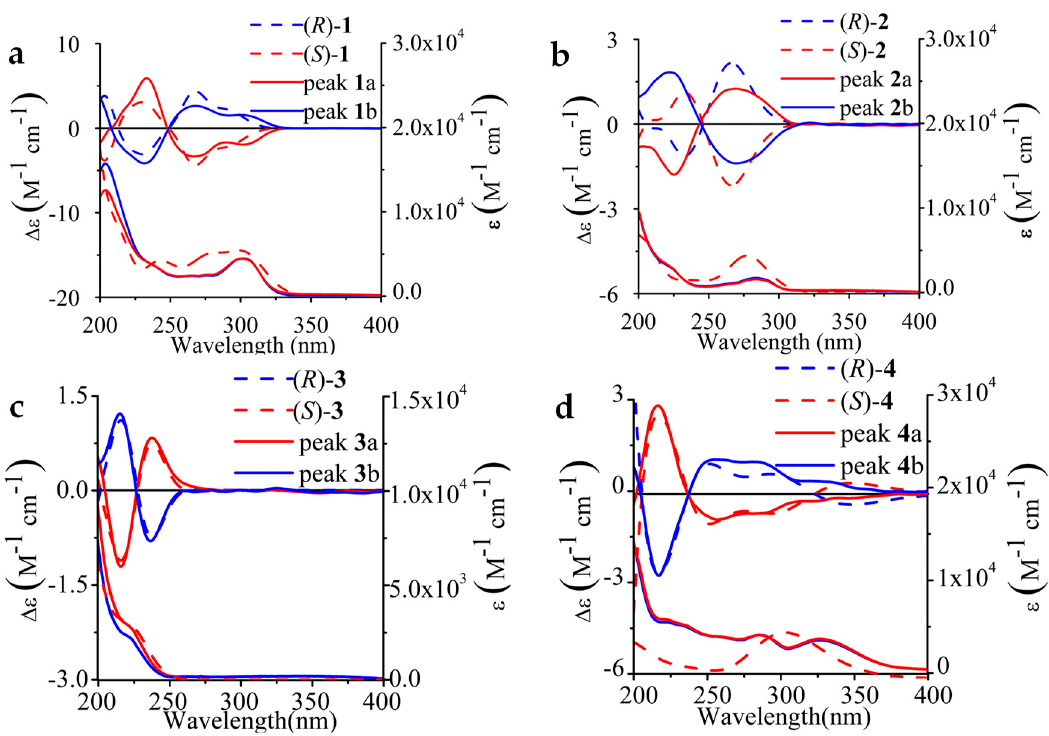
Figure 3. Comparison of experimental and calculated ECD (top) and UV (bottom) spectra of the stereoisomers ( a – d ). Solid: experimental in methanol, Dashed: theoretical values, and UV-corrected, bandwidth of 1 – 4 is 0.20 eV, 0.30 eV, 0.30 eV, and 0.40 eV, respectively. The enantiopure isomers of 1 – 4 were prepared under the optimal separation condition of our study, on ChiralPak AD-H, Chiralcel OD-H, ChiralPak AS-H and AD-H columns, respectively. Calculated spectra are Boltzmann averages from calculated spectra of each single